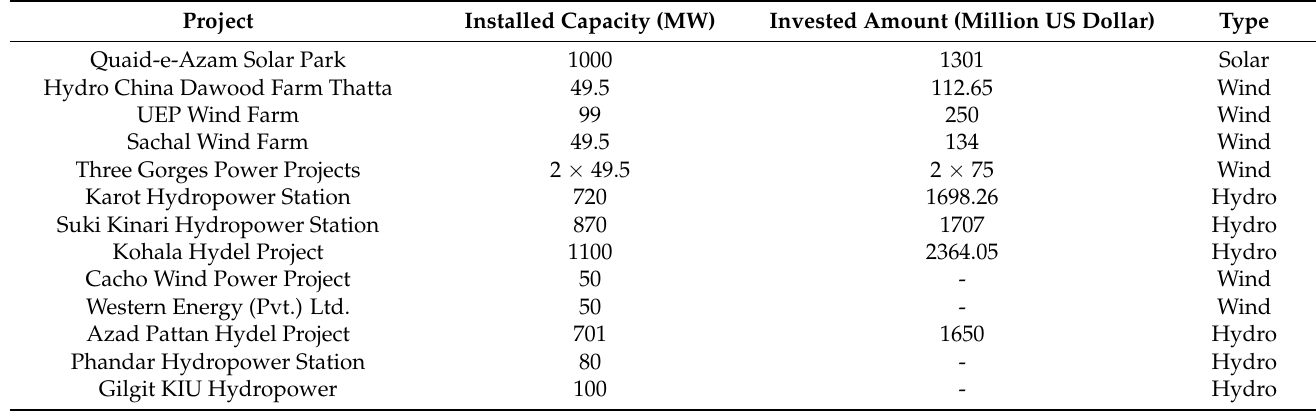
Table 1. Renewable Energy Projects under China–Pakistan Economic